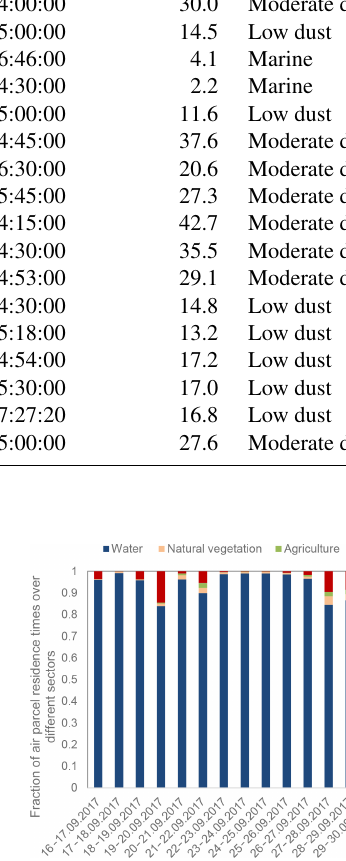
Figure 2. The residence time of the air masses calculated from 96h (4d) back trajectories in ensemble